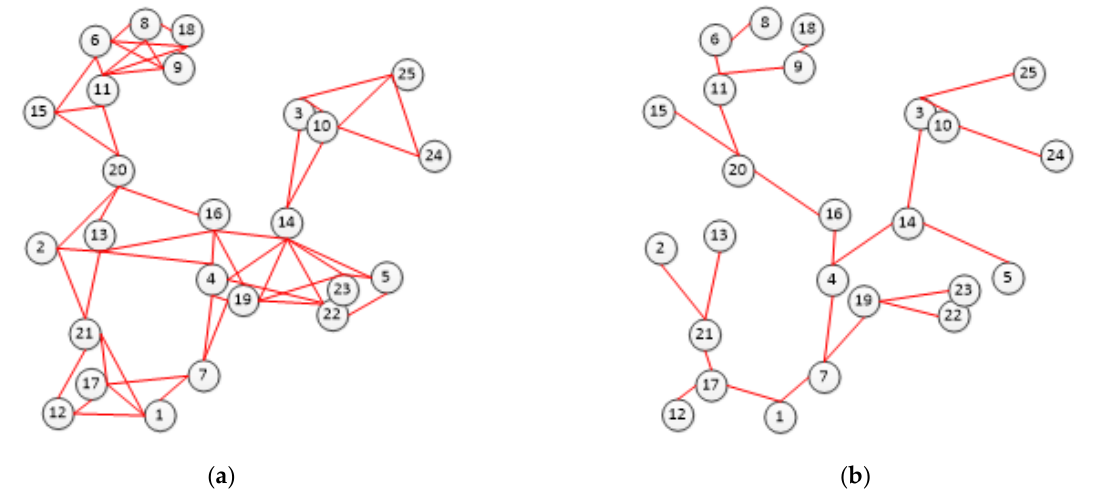
Figure 9. Network topology graph and routing tree constructed when the number of nodes is 25. ( a ) Network topology graph, ( b ) Routing tree.